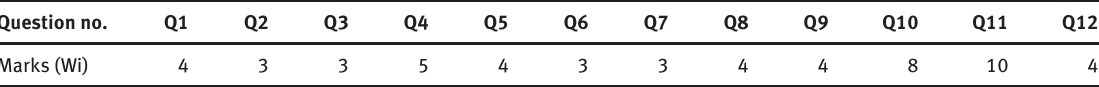
Table 1: Weightage of Each